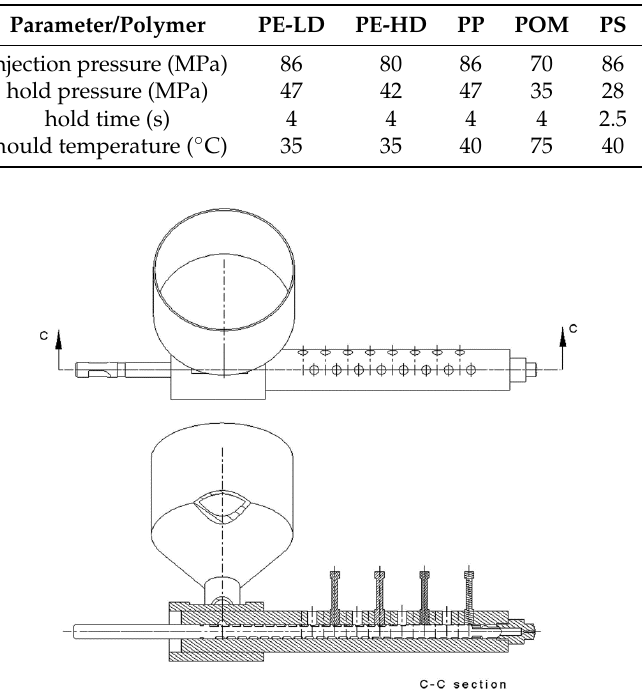
Figure 7. The arrangement of the holes in the barrel and the location of the pT sensors.